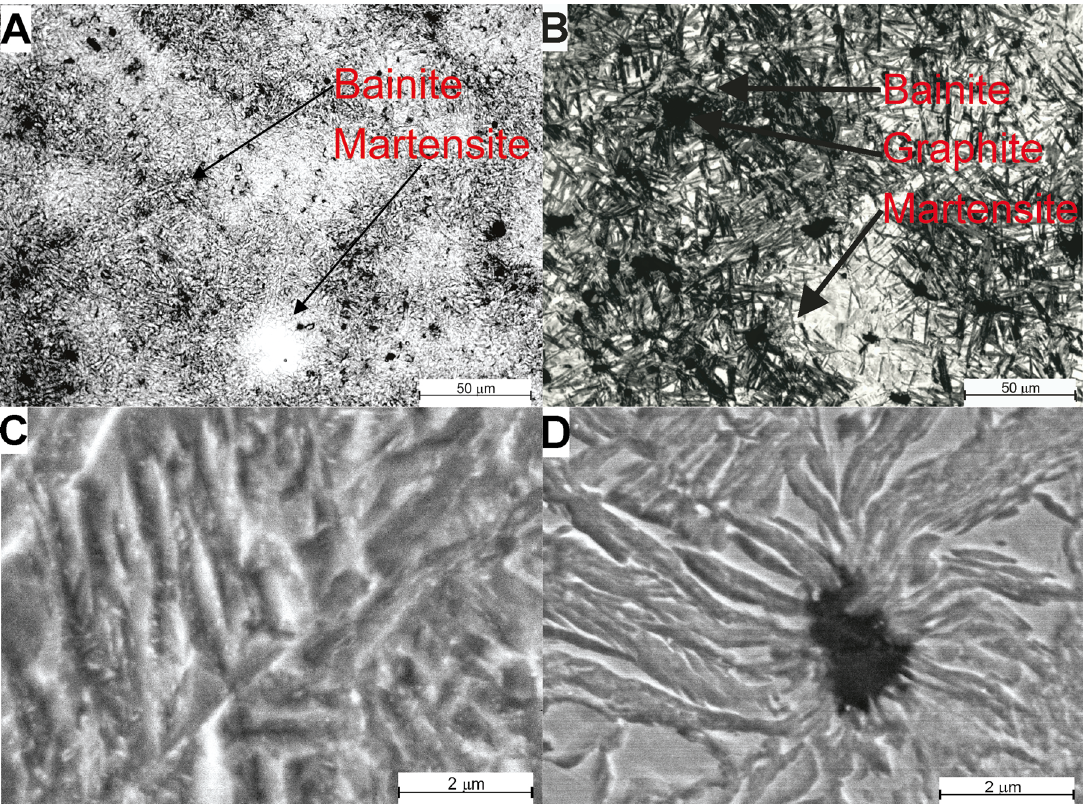
Figure 4. Optical (OM) and electronic (SEM) micrographs of the austempered samples corresponding to: (A) OM of base alloy (B) OM of base alloy + 3 %